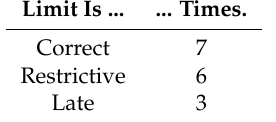
Table 7. Estimation of WaveDyn Validity using | η (cid:48) | < 0.549m/s. Limit Is